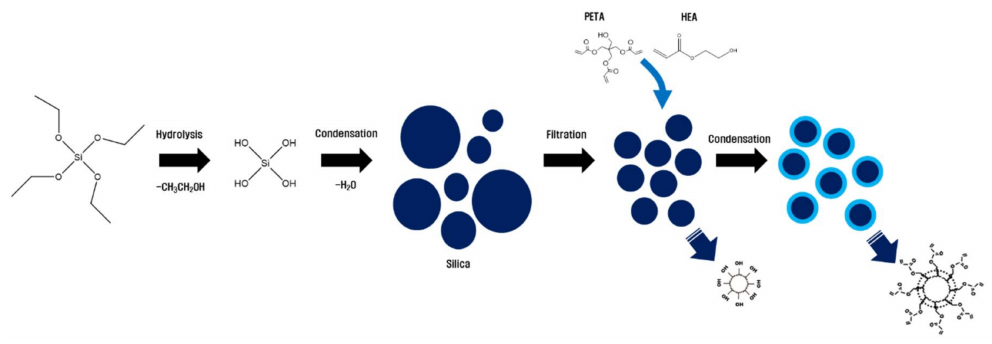
Figure 2. Preparation of the nano-silica core (NSC) and NSC multi-functional acrylate. PETA: pentaerythritol triacrylate; 2-HEA: 2-hydroxyethyl